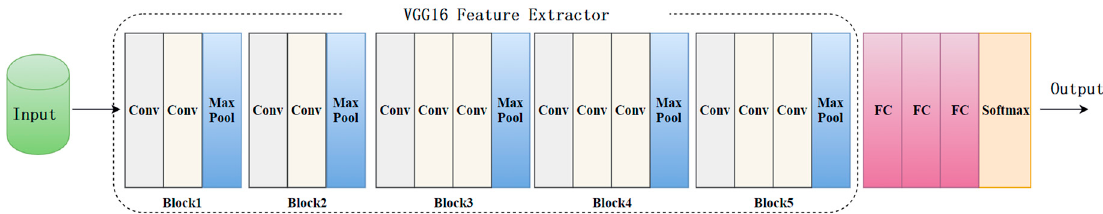
Figure 3. VGG16 network structure.